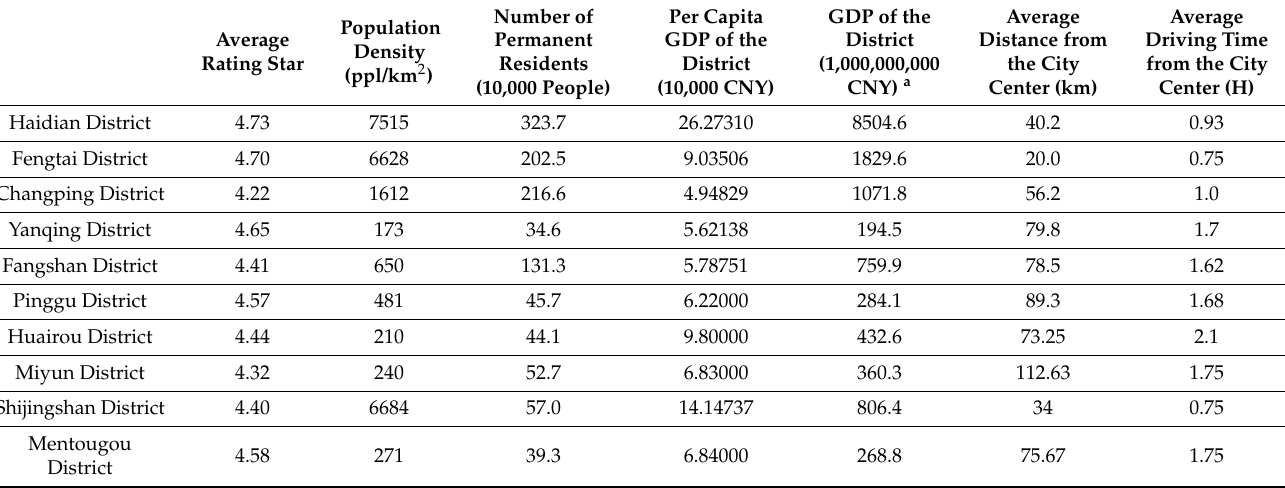
Table 8. Correlation analysis. Table 7. Factors of different administrative regions were used in the correlation analysis.